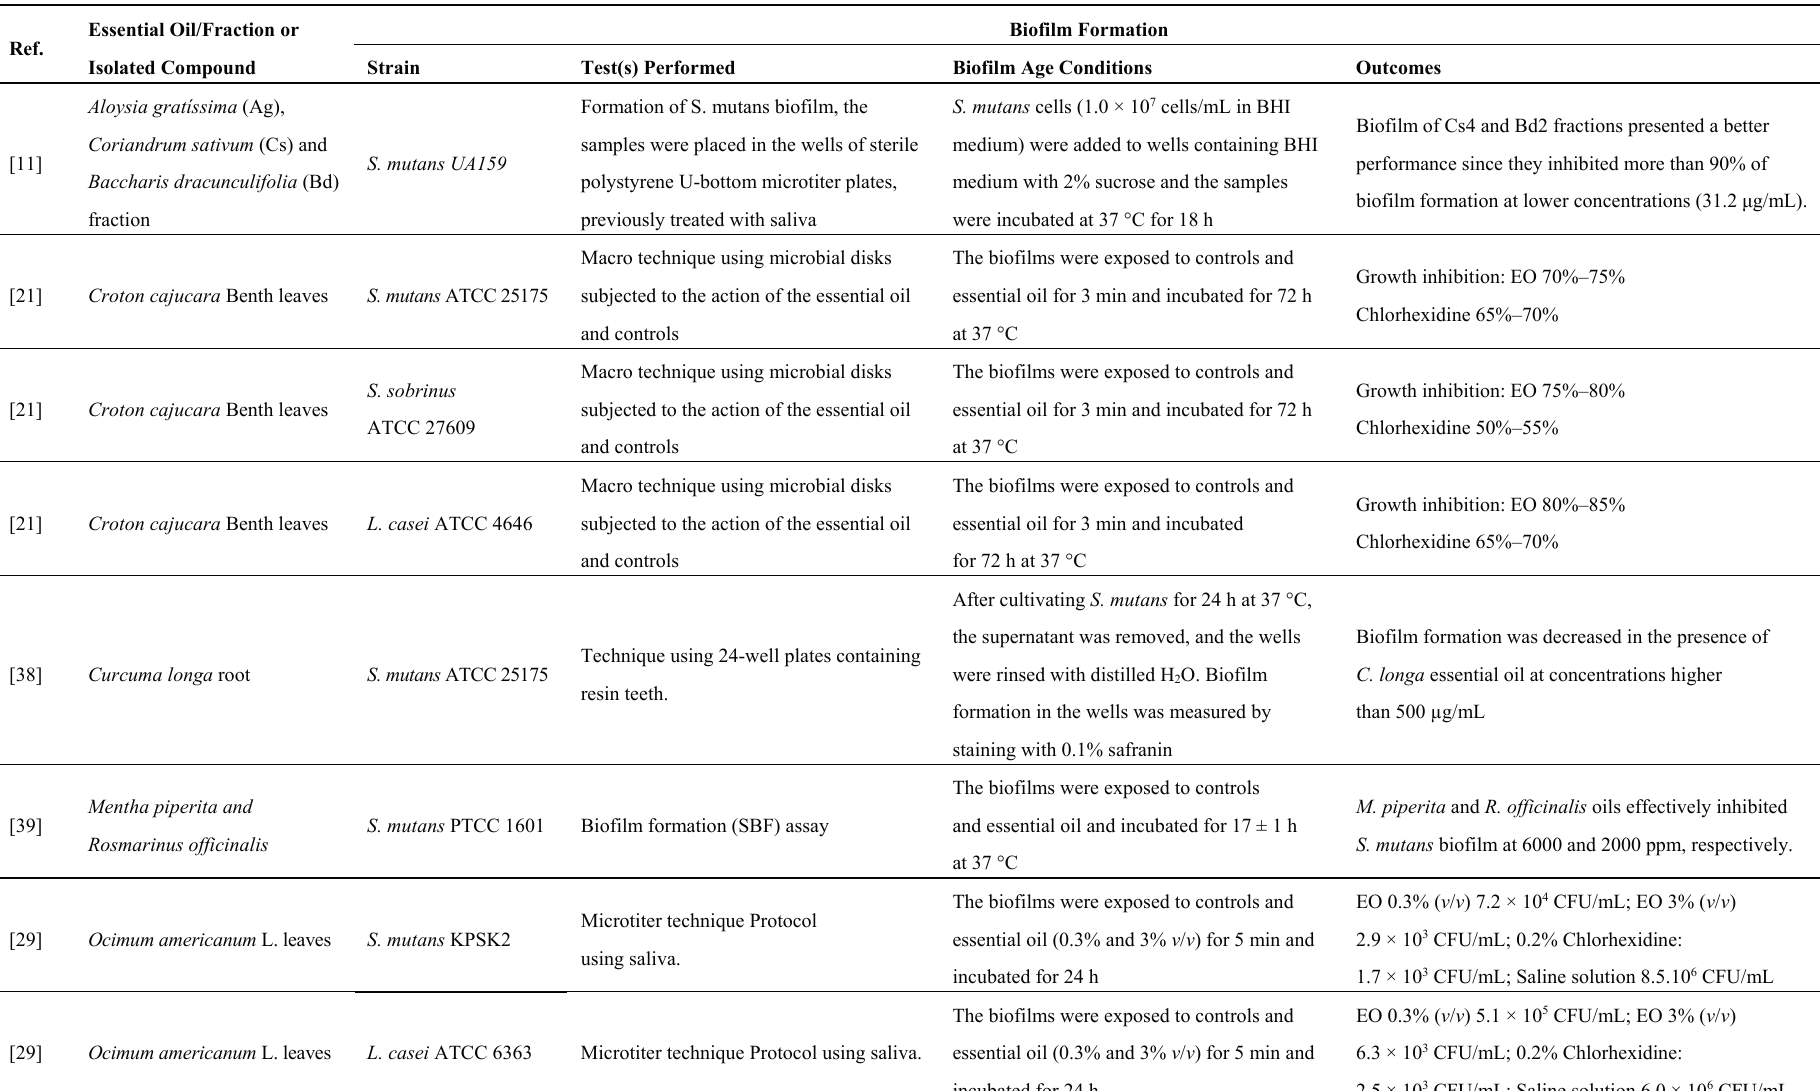
Table 7. Essential oils, fractions or isolated compounds against in vitro oral biofilm